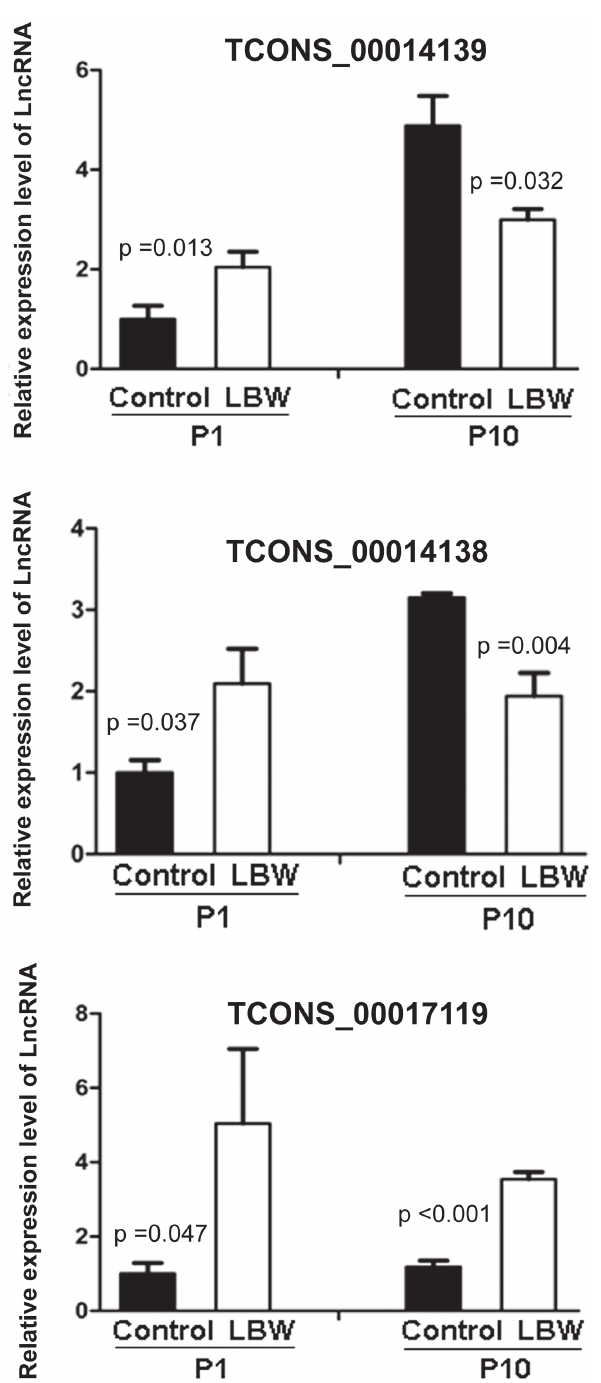
Fig 4. LncRNAs expression in the kidneys of low birth weight rats compared with controls. Comparison of the expression of lncRNAs in kidney between low birth weight (LBW) and control rats at postnatal day 1 (p1) and day 10 (p10) by quantitative real-time PCR. The level of lncRNA was calculated relative to GAPDH. The data are expressed as relative to the controls at p1. Values are means with SEM. p values for comparison of lncRNA level between LBW and control rats was calculated by the Student ’ s t-test (n = 7).